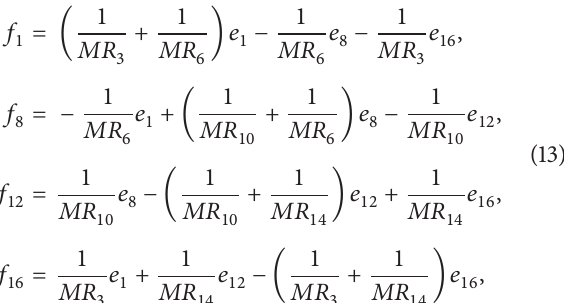
Figure 9: Bond graph model of the